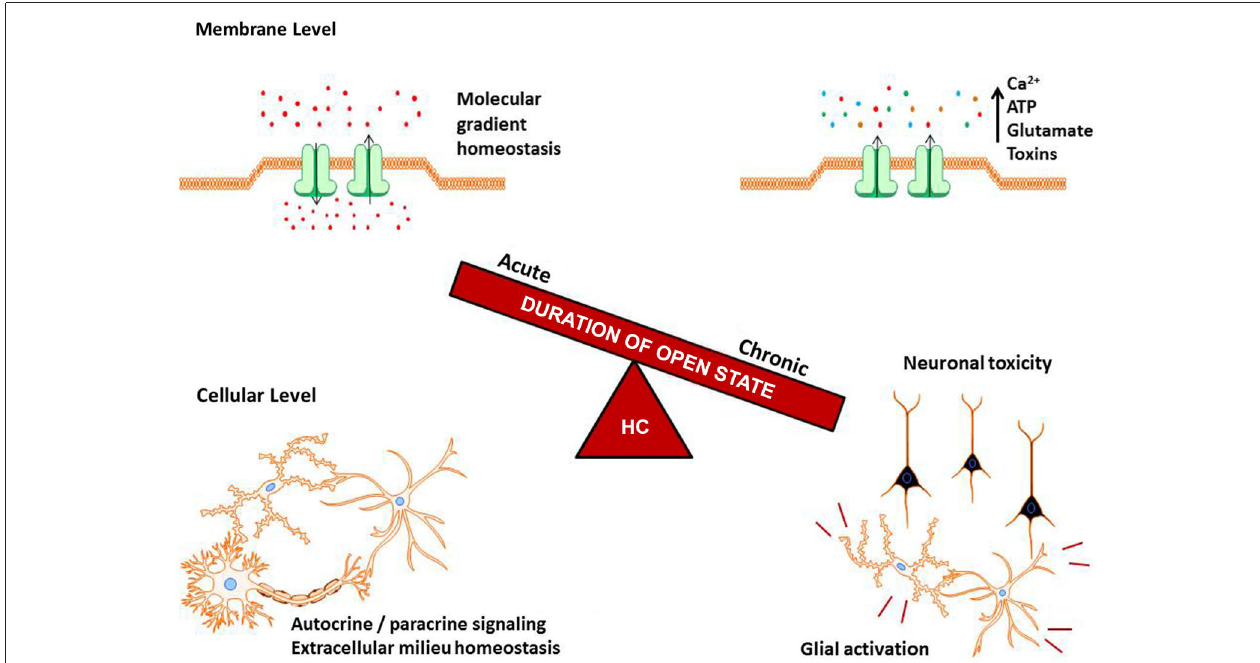
diseases and inflammatory signals, causes increased HC opening. Chronic HC activity can result in the ablation of vital molecular gradients, toxin release into the extracellular milieu, and potentiation of glial activation and neuron